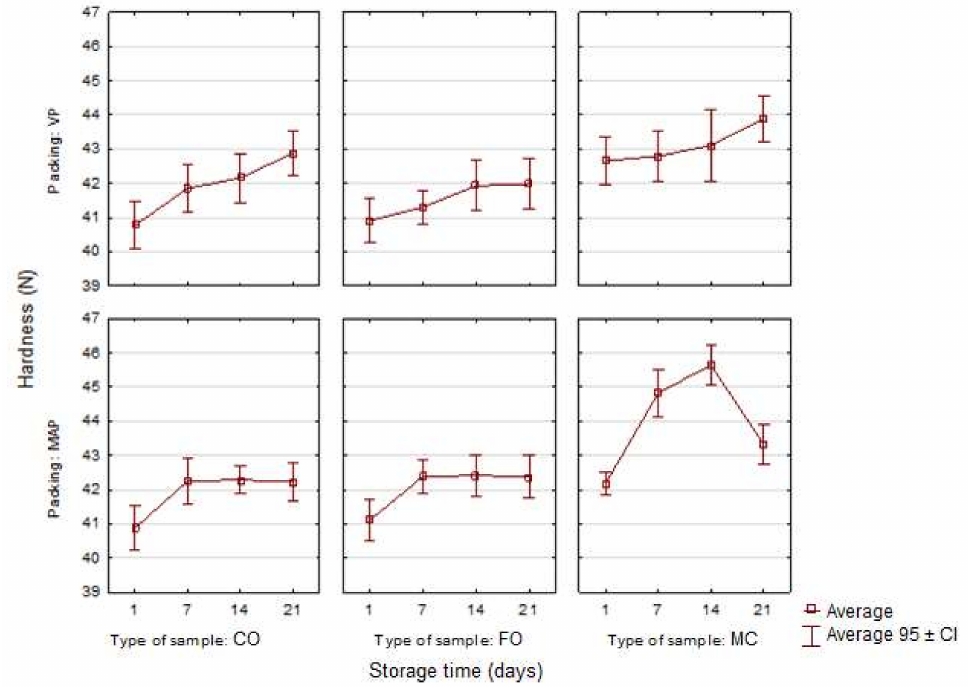
Figure 4. Changes in the hardness in the poultry sausages depending on the type of sample, packing and storage time ( n =